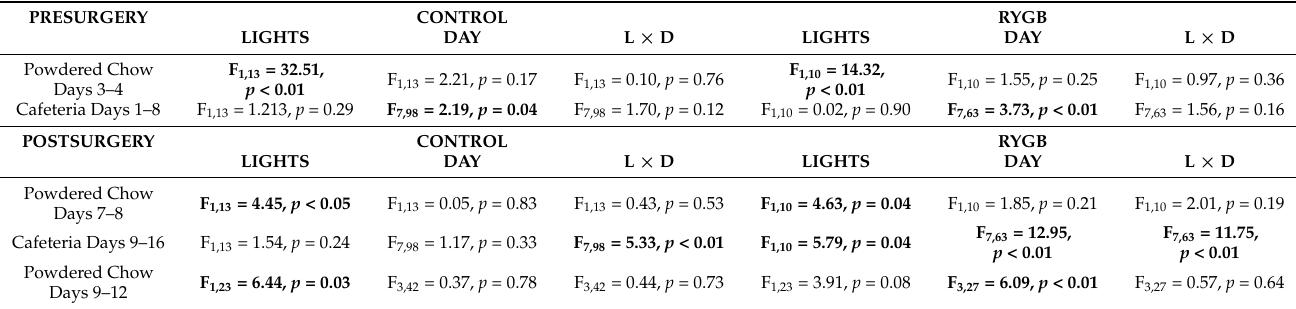
Table 15. Two-way ANOVAs Comparing Lights-On to Lights-Off Meal Sizes within Groups for Each Diet Condition.